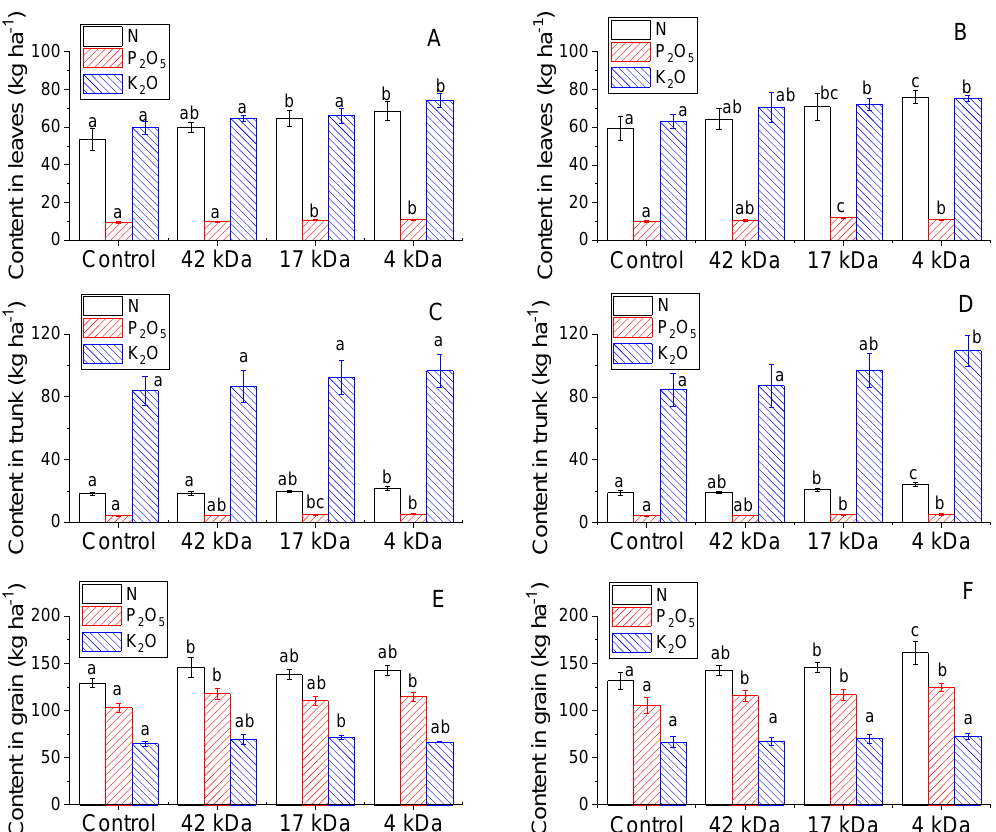
Figure 7. Influence of MWs on nutrient uptake determined in leaves ( A and B ), in trunk ( C and D ) and in grain ( E and F ) collected in 2018 (left) and 2019 (right). Bars represent mean values of three replicates ± standard deviation. Different letters indicate significant differences ( p < 0.05).